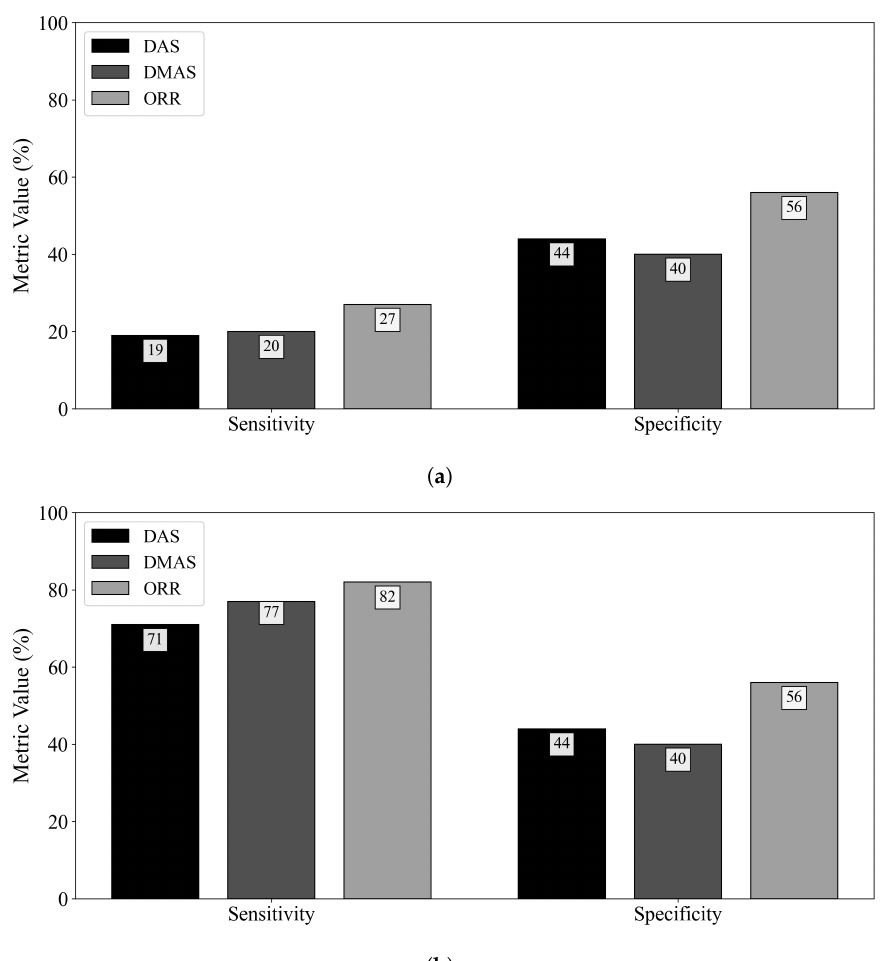
Figure 3. Sensitivity and specificity of the DAS, DMAS, and ORR reconstruction methods evaluated on UM-BMID Gen-3 when ( a ) the adipose-only scan is used as the reference and ( b ) when the adipose-fibroglandular scan is used as the